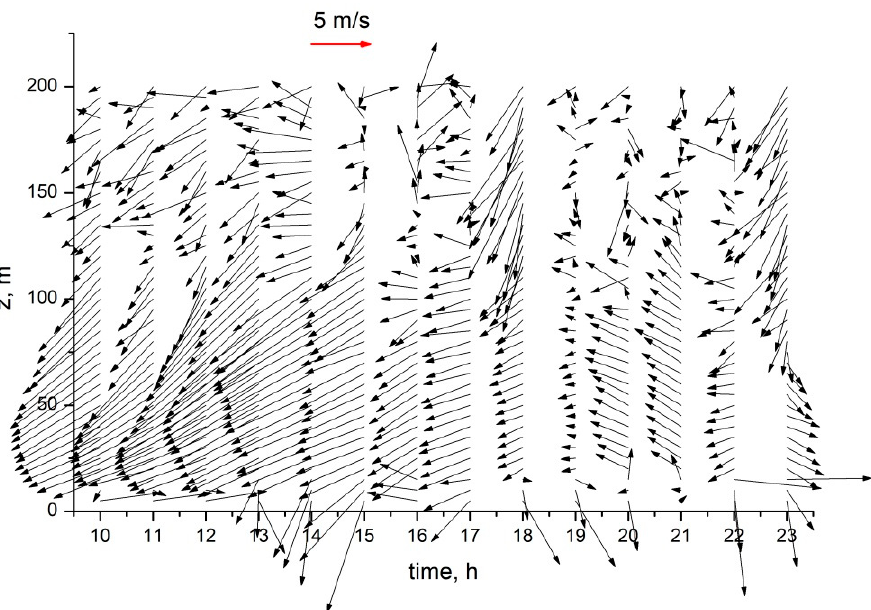
− V ( z , t ) (northern direction—upwards,    , z t V (northern direction—up ‐